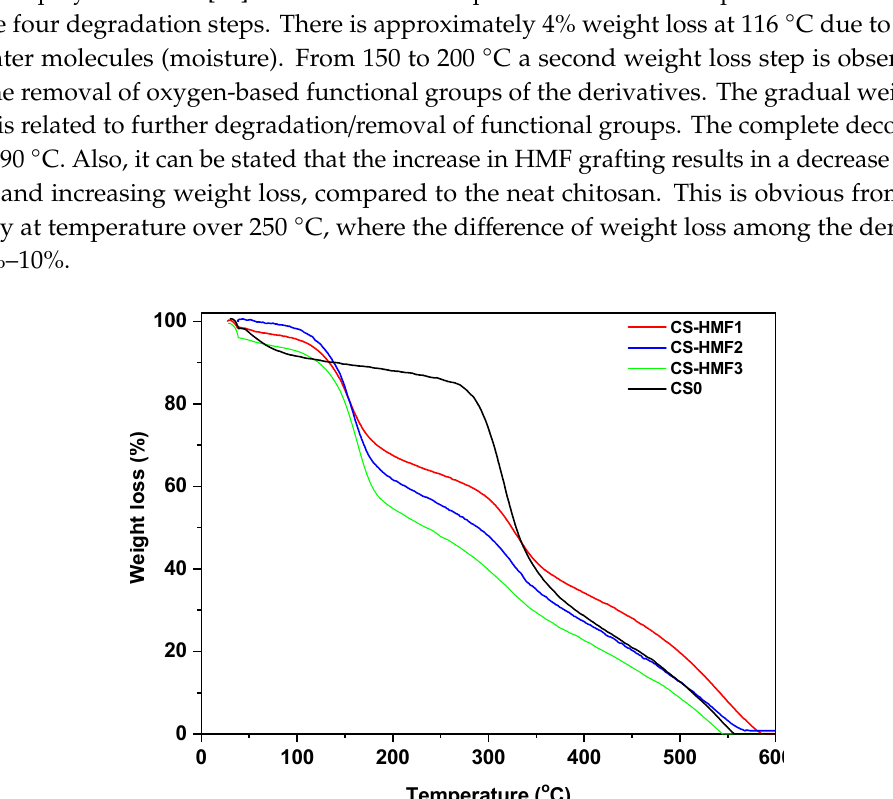
(b) Figure 5. Effect of pH on the removal of (a) Cu 2+ and (b) Cd 2+ by CSO, CSO-HMF1ad, CSO-HMF2ad, CSO-HMF3ad. Experimental conditions: C 0 = 100 mg/L, V = 20 mL, N = 160 rpm, T = 25 °C, t = 24 h, m = 0.02 g.